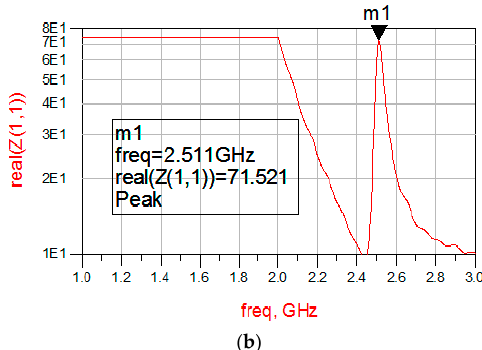
Figure 8 . Frequency response curve of the SMR measured by a network analyzer: ( a ) in fluid; and ( b ) in air.